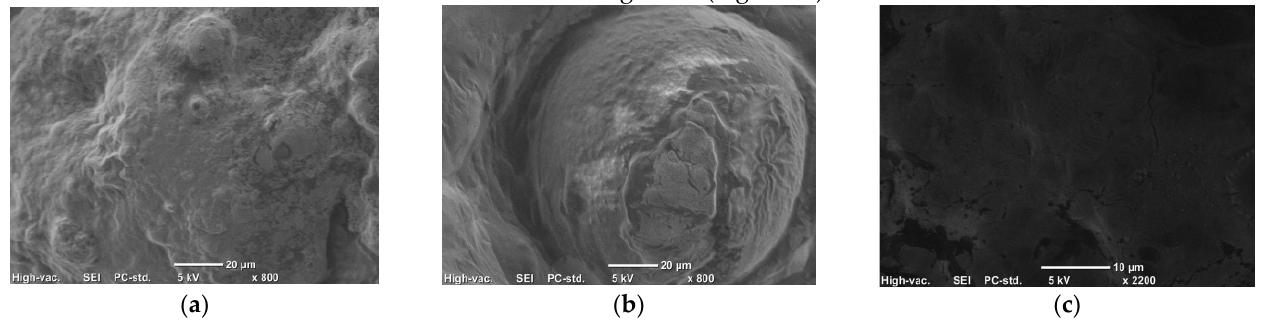
Figure 5. Homogeneity of emulsions based on different types of olive oil: ( a ) Refined olive oil; ( b ) Ozonated olive oil 0.04 mole O 3 /100 g oil; ( c ) 0.10 mole O 3 /100 g oil; Scanning-Electron Microscope JEOL JCM-6000.